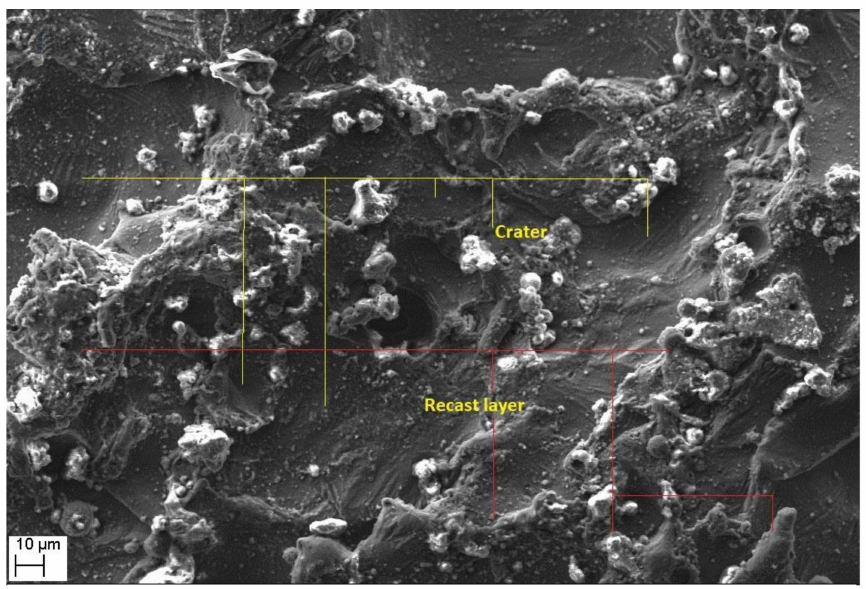
Figure 8. Magnified view of the recast layer and craters.